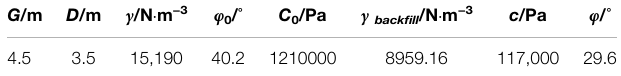
TABLE 13 | Physical and mechanical parameters of the West Bokaro open-pit mine 5 # coal obtained after average calculation and treatment. G /m D /m γ /N · m −